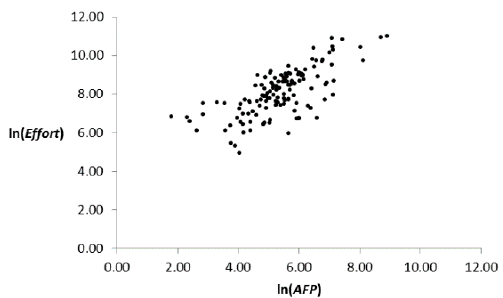
Figure 5. Transformed data of Figure 4.